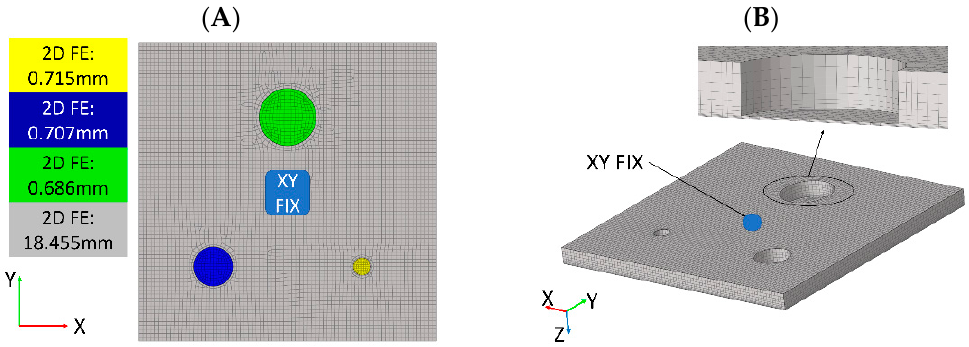
Figure 6. Formulated numerical models based on 2D FEs ( A ) and 3D FEs ( B ).